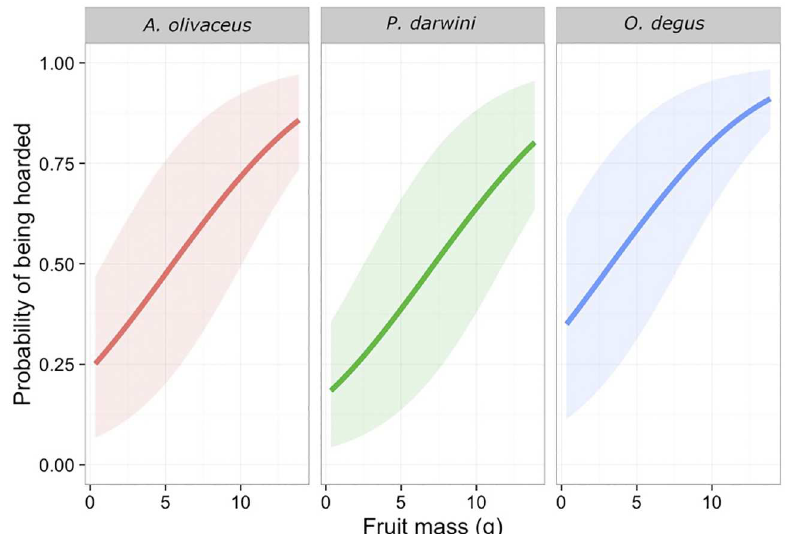
Fig 3. Relationship between fruit mass and the probability of a fruit that was harvested for consumption to be transported to a hoarding site by A . olivaceus , P . darwini and O . degus . The results were modeledusing a mixed effects logistic